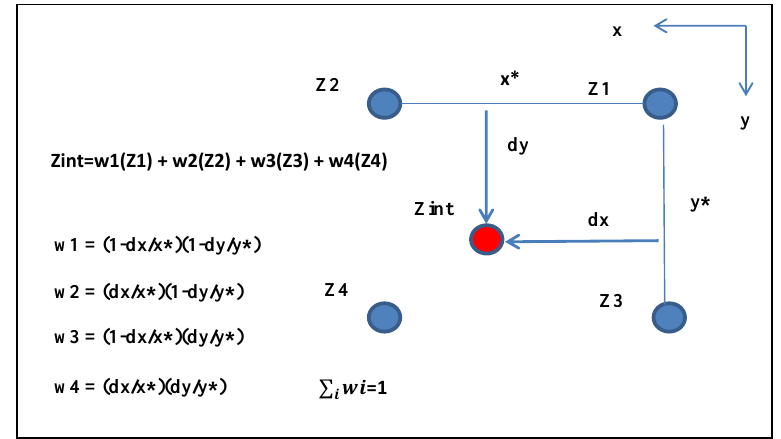
Figure 11. Bilinear interpolation of four surrounding grid